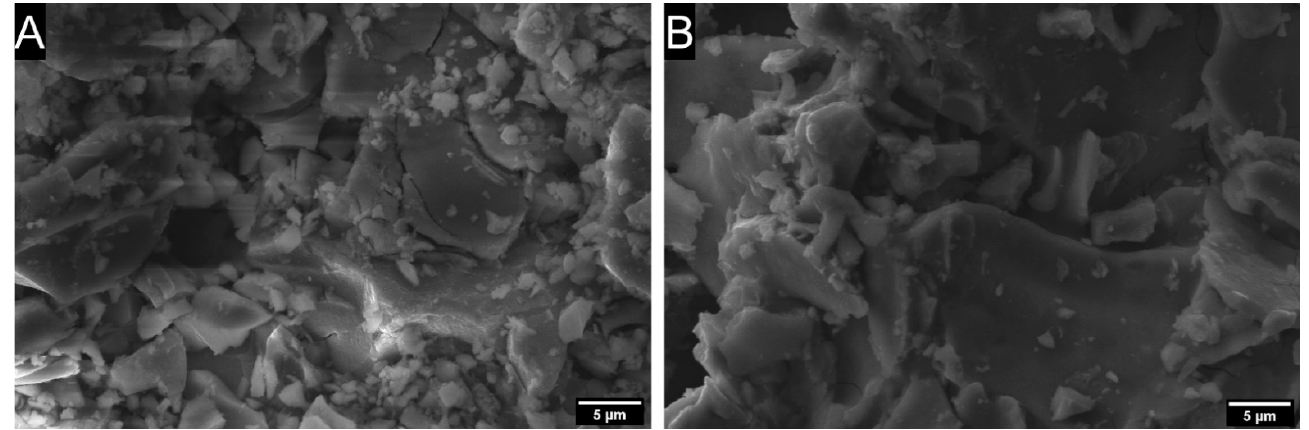
Figure 2. SEM images of immobilised ( A ) TiO 2 and ( B ) rGO/TiO 2 on surface of glass substrate before use.